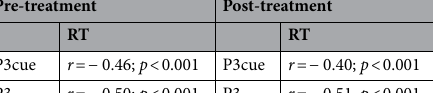
Table 2. Pearson correlation between P3cue and P3 with RT, for pre- and post-treatment.